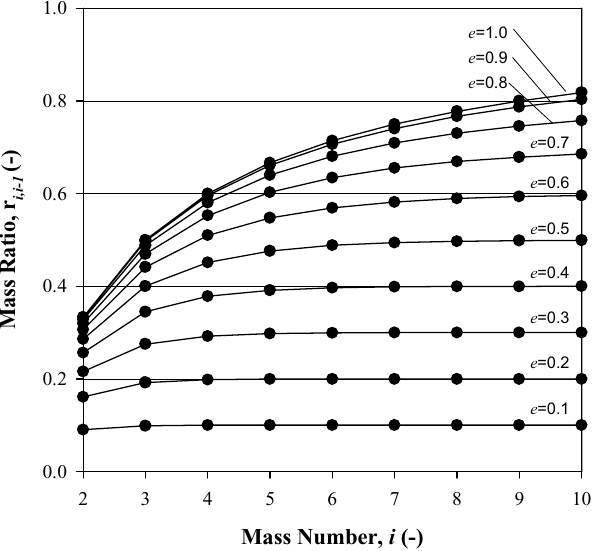
Fig. 10. Pair-wise mass ratios r i,i − 1 versus mass number for varying coefficient of restitution in a vertically-stacked MET configuration. (-) means non-dimensional.